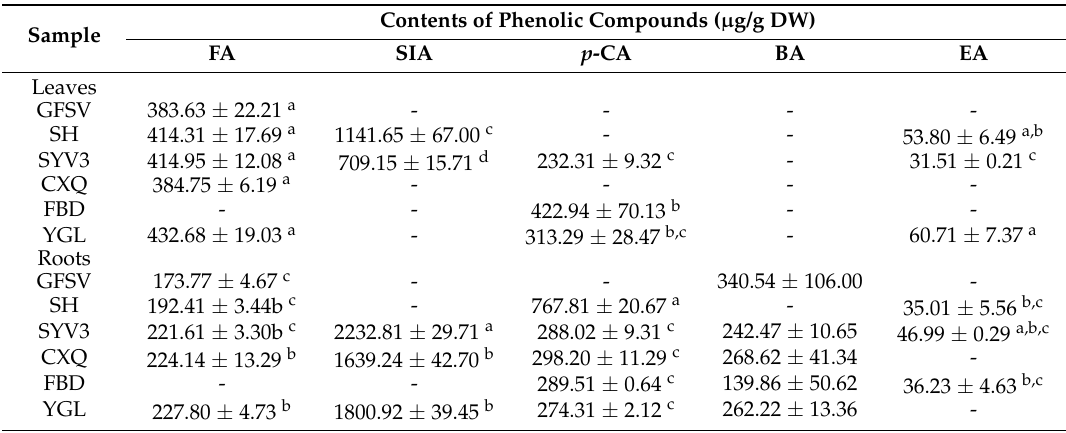
Table 5. Phenolic compounds of conjugate extracts of Phal. hybrids base on: FA, SIA, p -CA, BA, and EA. Contents of Phenolic Compounds ( µ g/g DW) Sample FA SIA p -CA BA EA Leaves